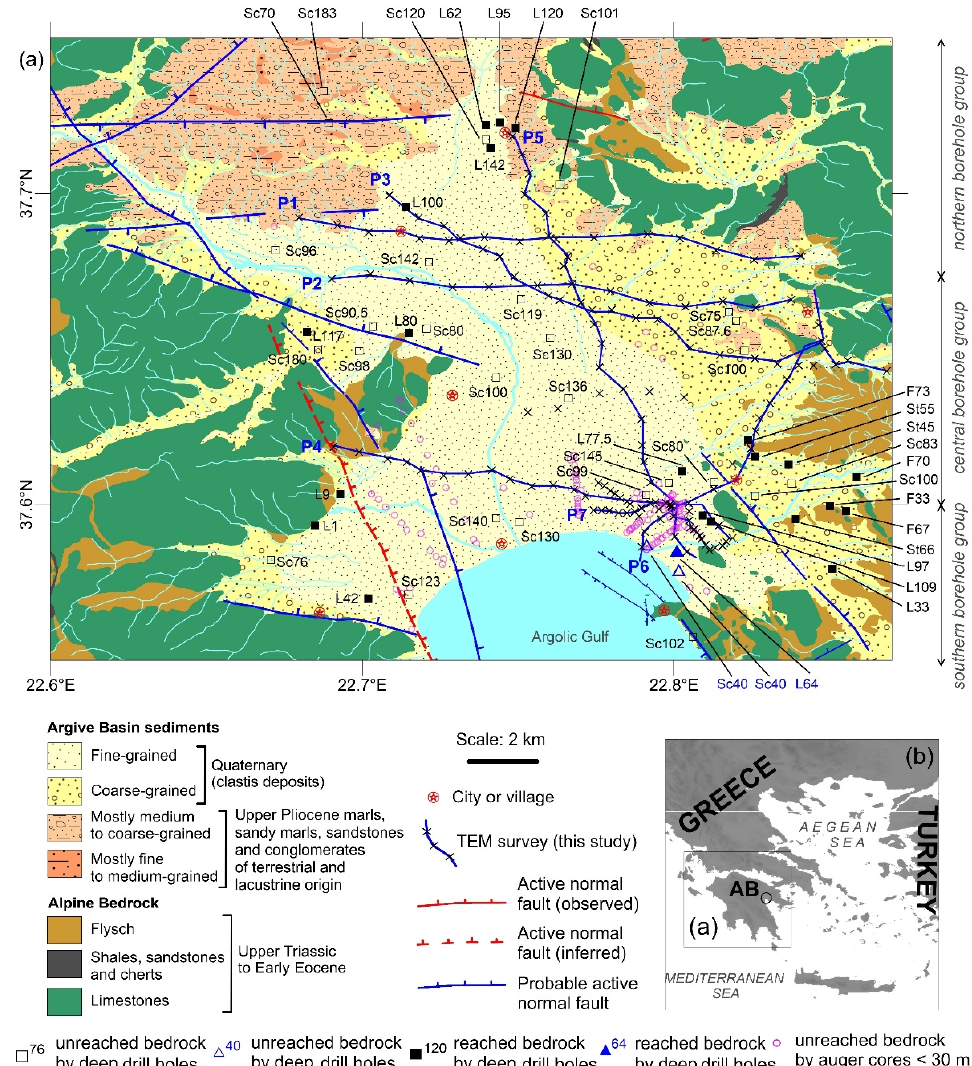
Figure 1. ( a ) Geologic map of the Argive Basin, Peloponnese, Greece (after Hinojosa-Prieto [30]) showing the distribution of the present TEM deployment, shallow drill holes (pink open circles: <30 m by Zangger [21]), and shallow drill holes (indicated by black open and filled squares: 30–185 m by Greek Service of Land Improvement [GSLI], unpublished data; blue open and filled triangles 40–64 m by Karastathis et al. [23,24]). Pink open circles correspond to shallow soil drill holes that did not reach the bedrock. Black open squares and blue open triangles correspond to shallow drill holes that did not reach the bedrock with drilling depth shown by adjacent numbers. Black-filled squares and blue-filled triangles correspond to shallow drill holes that reached the bedrock with depth to bedrock shown by adjacent numbers. ( b ) Index map of the Aegean region.